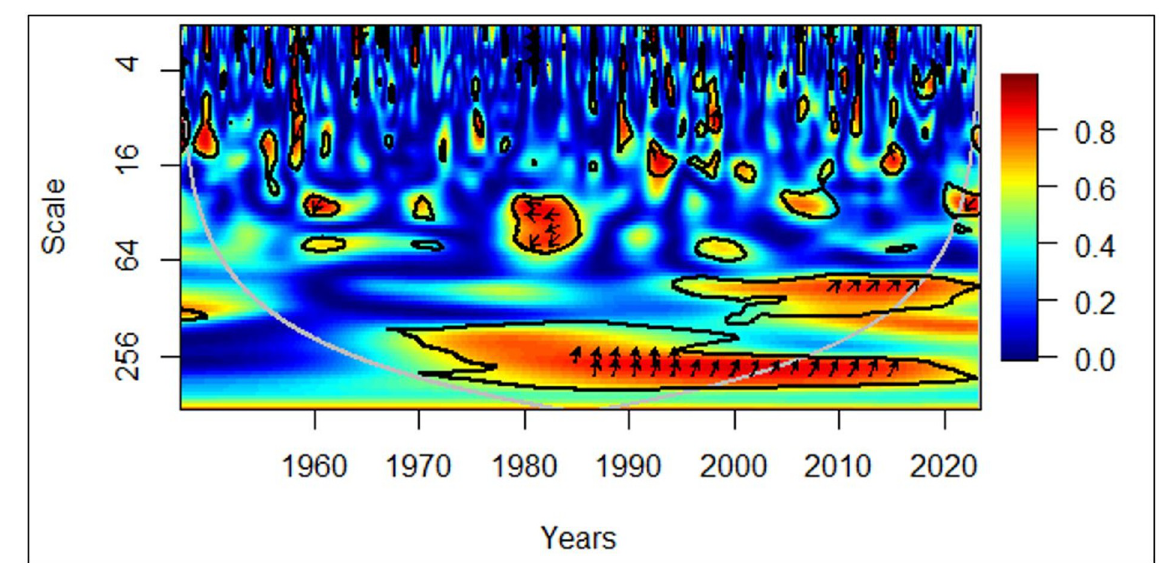
Fig 5. African region: GDP vs EPOP. Source: Authors’